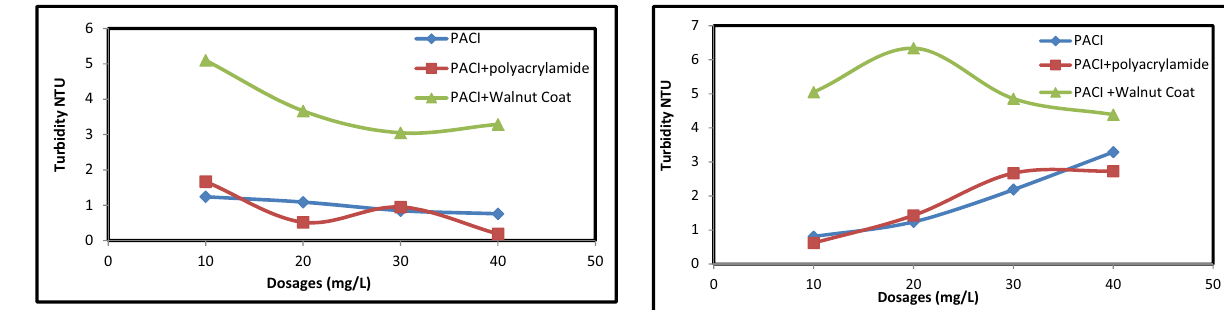
Figure 20: The relationship between a coagulant aid and fi nal tur - bidity for water sample at 180 cm height.